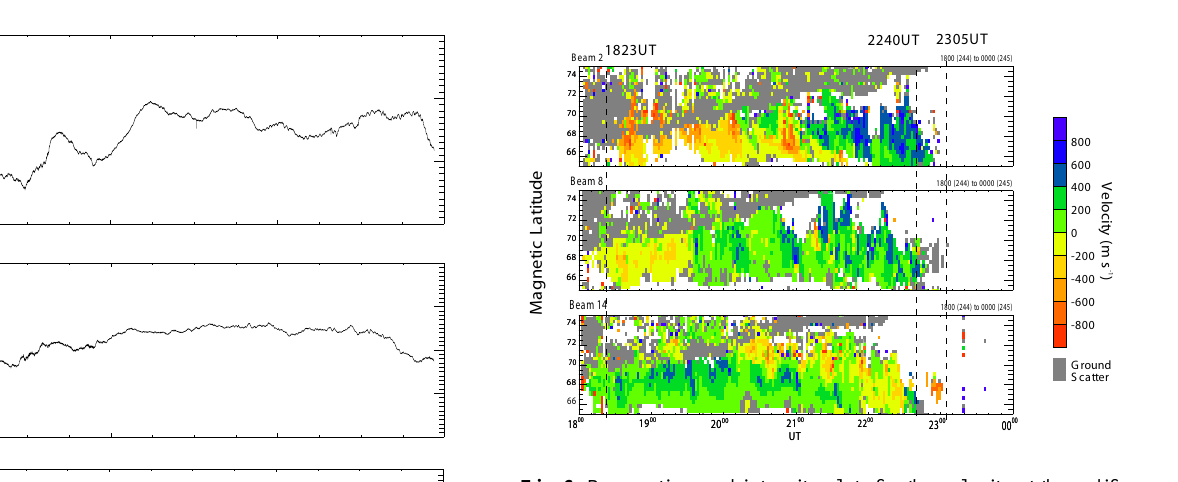
Fig. 6. Range, time and intensity plots for the velocity at three dif- ferent beams (2, 8 and 14) of the Hankasalmi (Finland) radar dur- ing the 18:00 to 24:00 UT interval. Vertical dashed lines represent times of pseudobreakup at 22:40 UT and expansion phase onsets at 18:23 UT and 23:05